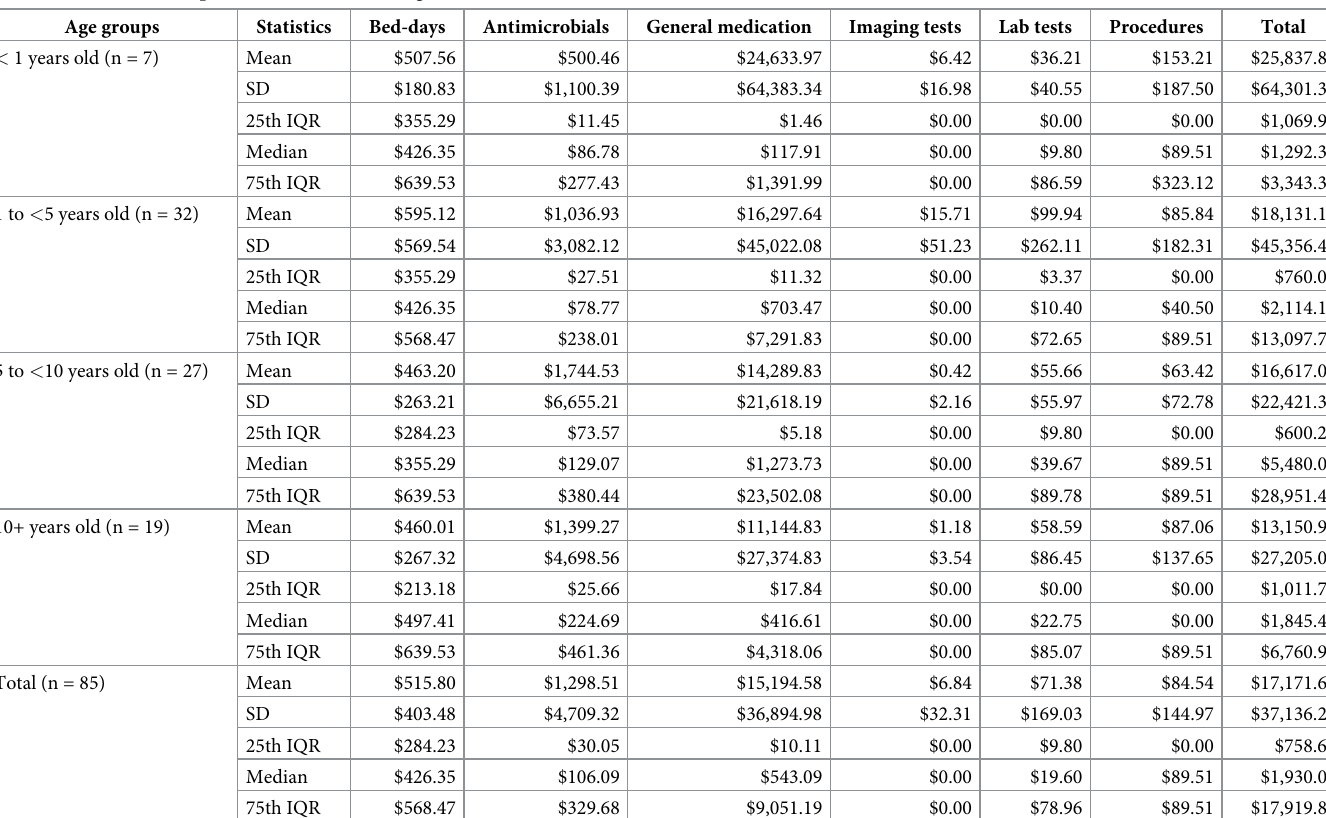
Table 3. Direct costs for patients treated for in the general ward